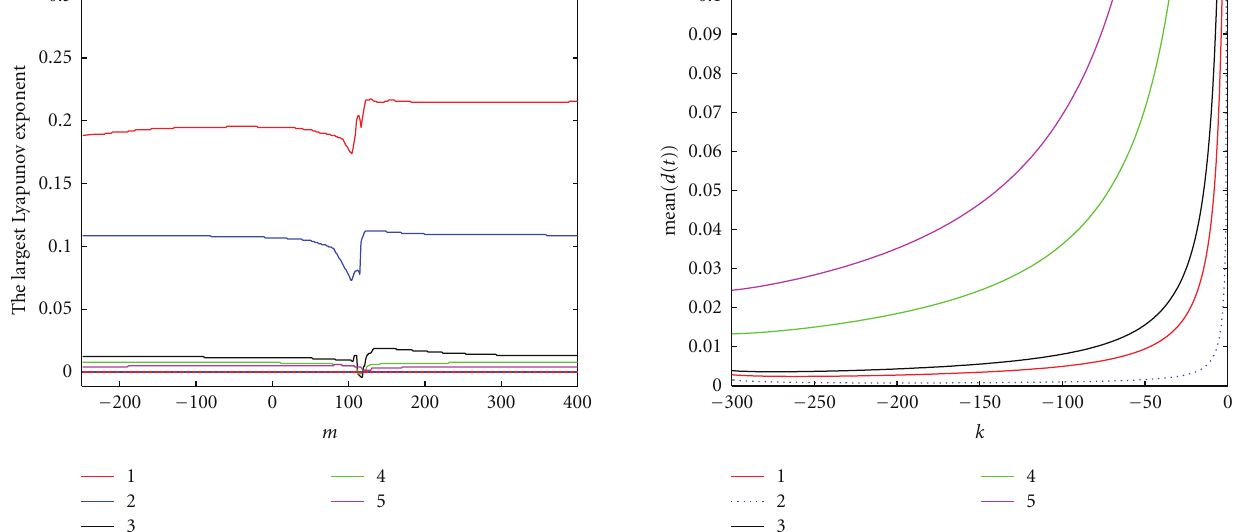
Figure 7: The relationship of mean ( d ( t )) and k . Curve 1 is with the our increased system (8) when m = 112 . Curve 2 is with the system (7) when h (cid:2) = h , φ = 0 , curve 3 for φ = 0 . 1 , curve 4 for φ = 0 . 5 , and curve 5 for φ = 1